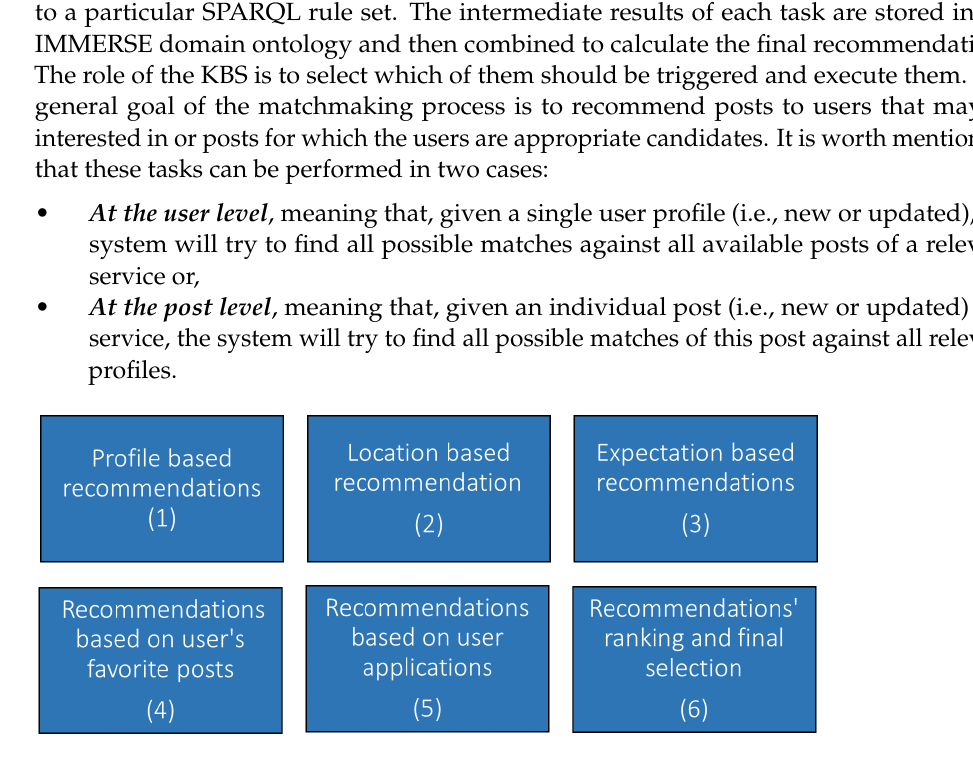
Figure 7. Individual reasoning